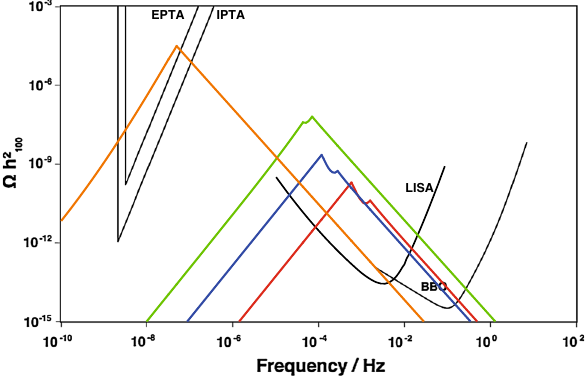
Fig. 10 This is the expected signal strength, expressed in terms of the gravitational wave contribution to the energy spectrum as a function of frequency. The parameters used in the plots are: (cid:11) = 0 . 1, v 0 = 0 . 1, v = 10, and f = 1 TeV and the three different colors correspond to 1 N = 6 (red), 9 (blue), 12 (green), and 20 (orange). In this plot the signal datacalculatedinthisworkisoverlaidonsensitivitycurvesderivedfrom [49], and available at http://rhcole.com/apps/GWplotter/ for BBO and the EPTA and IPTA. The sensitivity curve for LISA [50] was generated from the C1 curve provided in